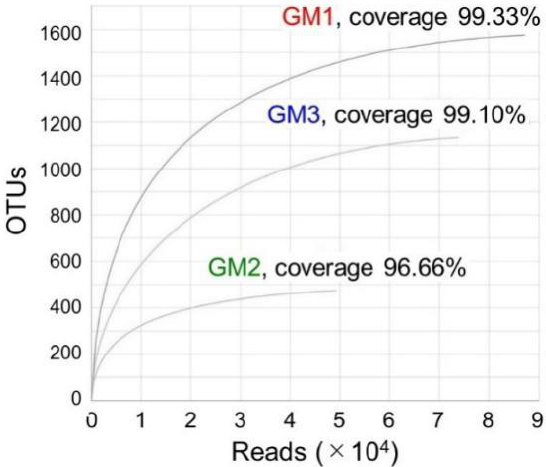
Figure 6. Rarefaction curves based on the numbers of reads and OTUs for the GM1, GM2 and GM3 speleothems.